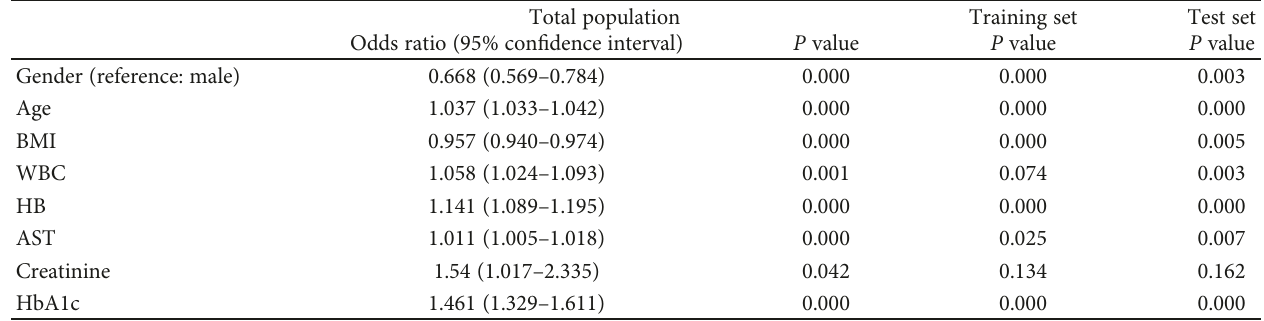
Table 3: Multivariate analysis of quartile CEA.